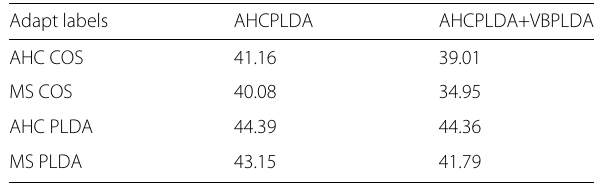
Table 3 DER(%) for the unsupervised adaptation in the evaluation set Dev. set Eval. set